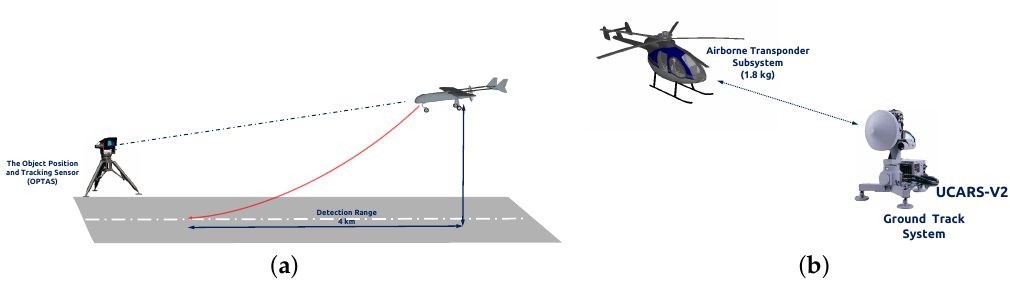
Figure 1. ( a ) The object position and tracking sensor (OPTAS) system is mounted on the tripod. Adapted from [7]; ( b ) UAS common automatic recovery system (UCARS) for MQ-8B autonomous landing. Adapted from